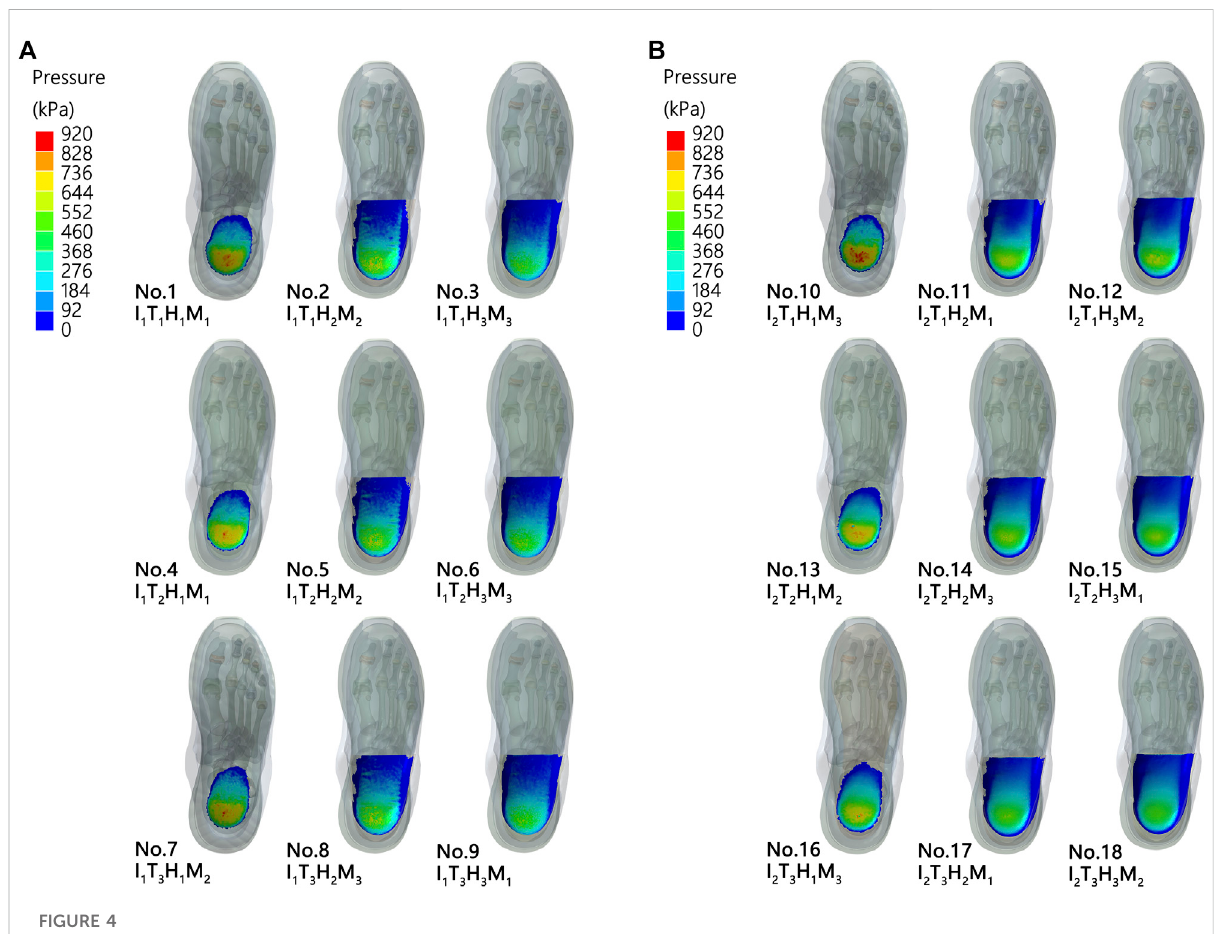
FIGURE 4 Heel pressure distribution with different shoe designs (A,B)